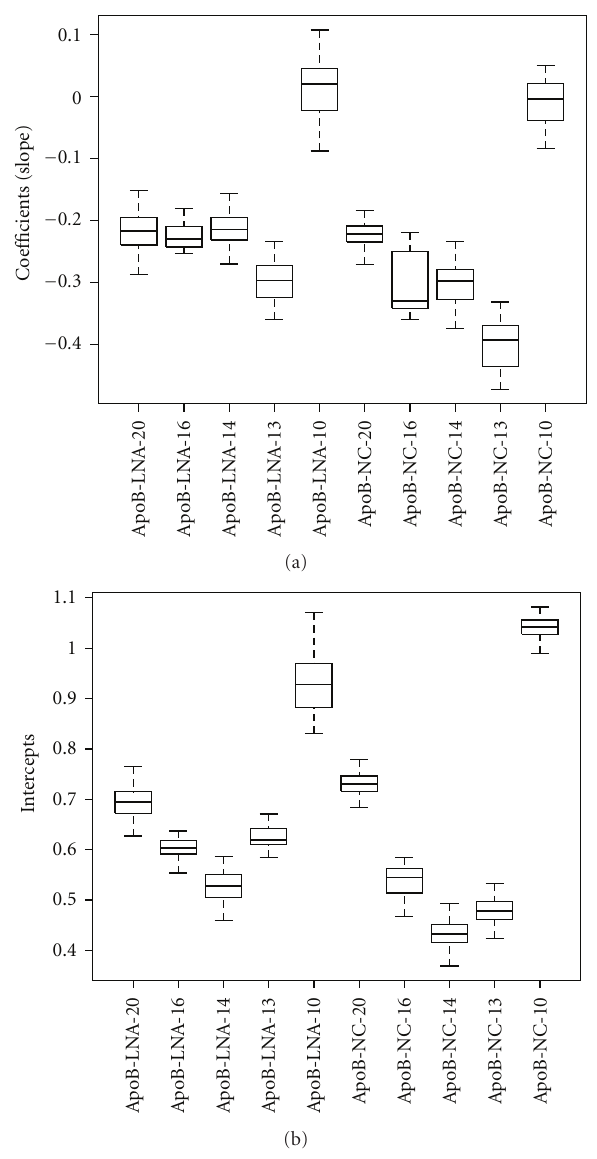
Figure 3: Boxplots of coe ffi cients and intercepts of regression lines obtained from cellular assay data. Bold lines in the box indicate medians. Top and bottom lines of the box indicate upper and lower quartile points, respectively. Top and bottom lines in contact with a dotted line indicate the highest and lowest data point, respectively. Open circles indicate outliers.